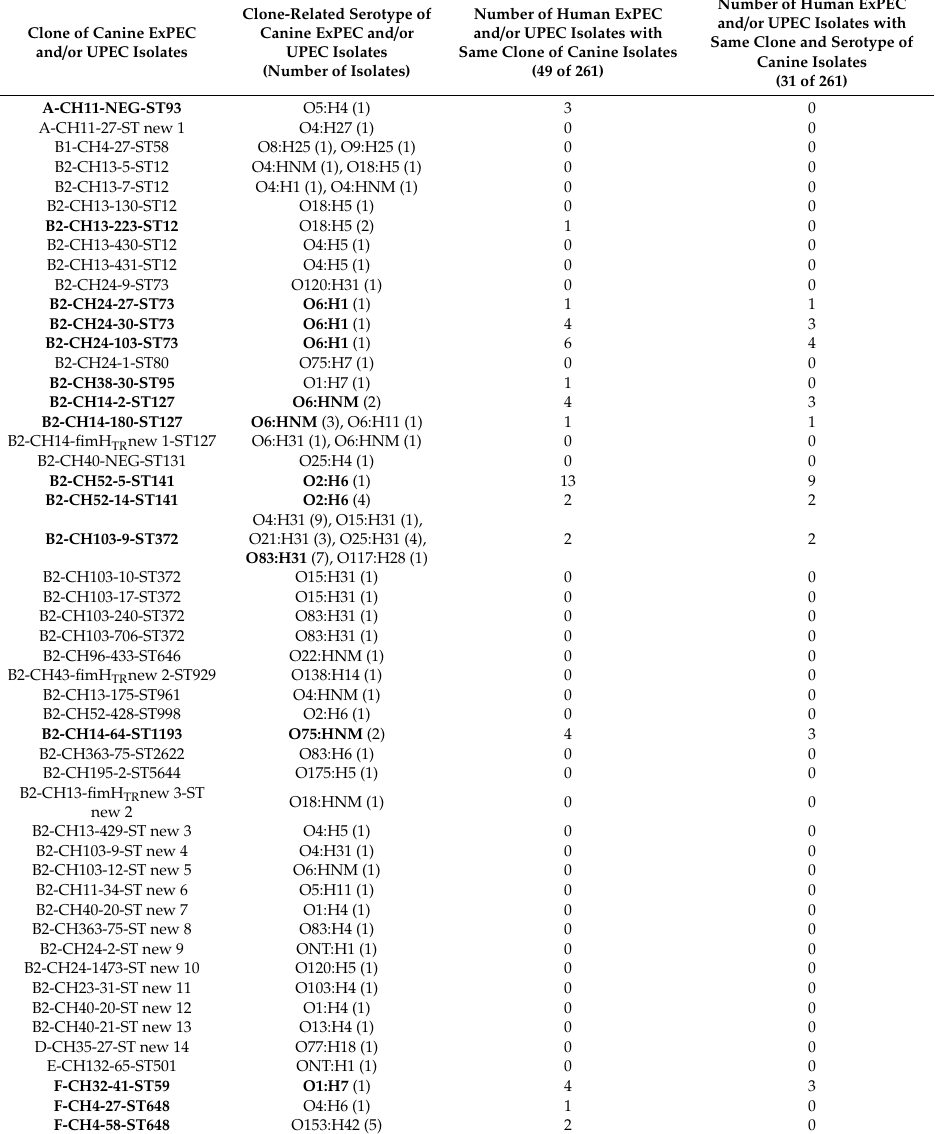
Table 3. Clones and clonal-related serotypes of 91 canine ExPEC and / or UPEC isolates. Prevalence of the canine clones and clonal-related serotypes among ExPEC and / or UPEC isolates causing extraintestinal infections in humans